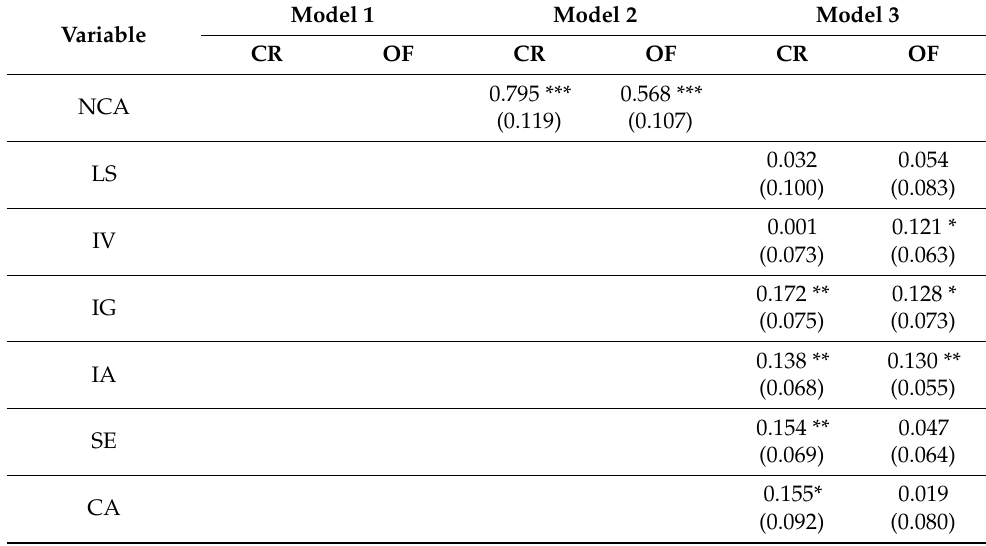
Table 2. Estimated results of the effect of NCA on farmer’s